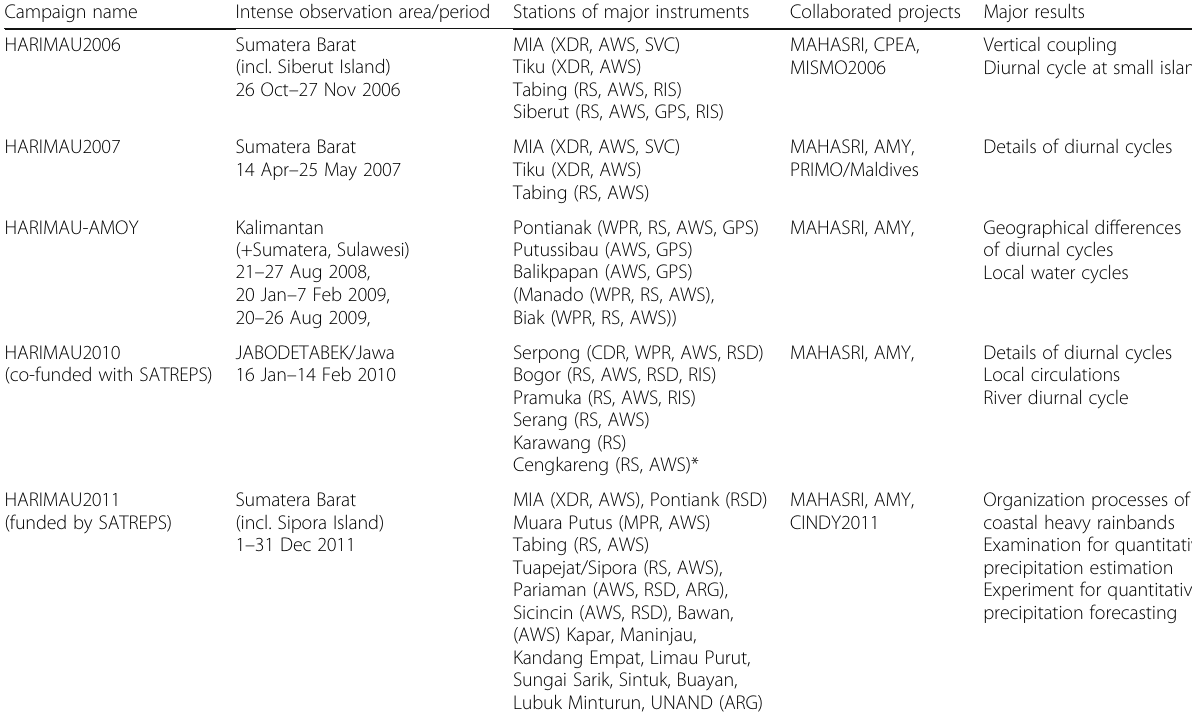
Table 2 Intense observation periods (IOPs) of the HARIMAU project under MAHASRI Campaign